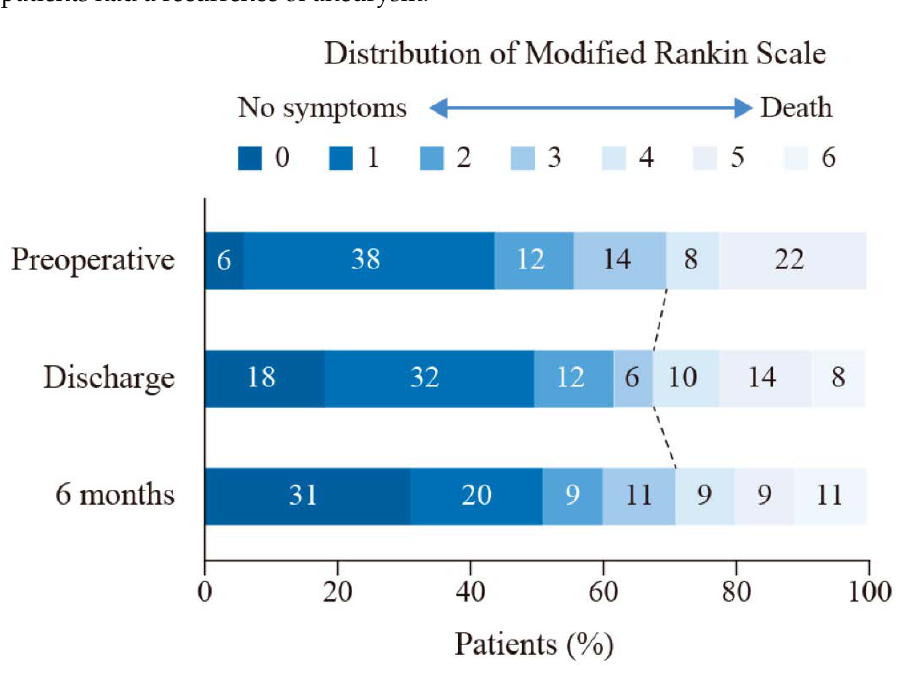
Figure 1. The distribution of modified Rankin Scale at admission, discharge, and six months. Shown are the percentages of patients at admission, discharge, and six months with scores from 0 to 6 on the modified Rankin